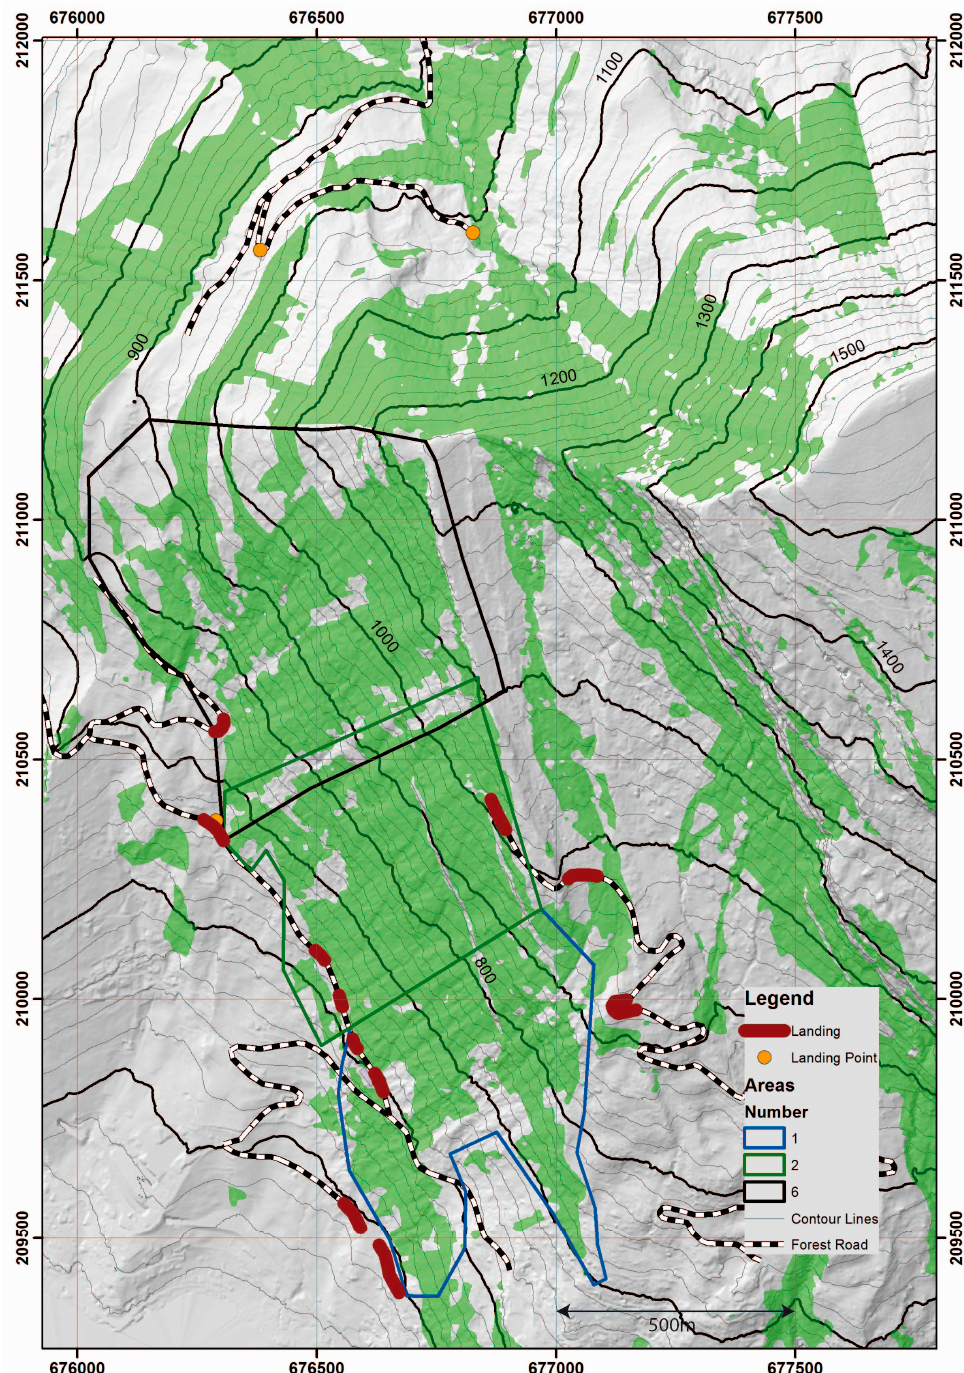
Figure 4. Rigi test areas. Here only sub-area numbers 1, 2 and 6 are displayed. Sub-areas 7, 8 and 9 are not displayed. Area 7 is composed of sub-areas of areas 6 and 2, area 8 covers areas 1 and 2, and area 9 covers the whole project area. Note that the landings and the forest road at the bottom right have a limited bearing capacity, leading to additional trans-shipment costs of 15 CHF / m 3 (hillshade map © swisstopo (JA100118)).